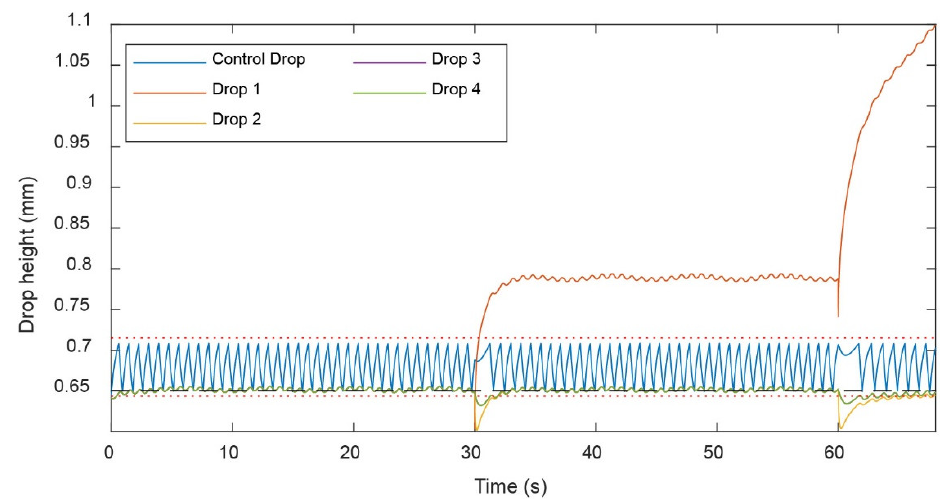
Figure 11. Matlab simulation showing the effect of wetting of the rim. The control drop height was set to 650 μm, indicated as black dashed line. Red dotted lines indicate the maximum and minimum drop heights of the control drop, as explained through the drop hysteresis in Figure 10B. The blue oscillatory pattern indicates the constant readjustment of the control drop height due to the pulsed withdrawal of excess medium through the needle-type outlet. The inflow rate was 80 μL/min, outflow rate was 15 μL/min for each drop, and the control needle outflow rate was 45 μL/min. A spontaneous wetting instance was simulated at 30 s and 60 s, where the aperture of drop 1 increased by 5% (10 μm) each time.